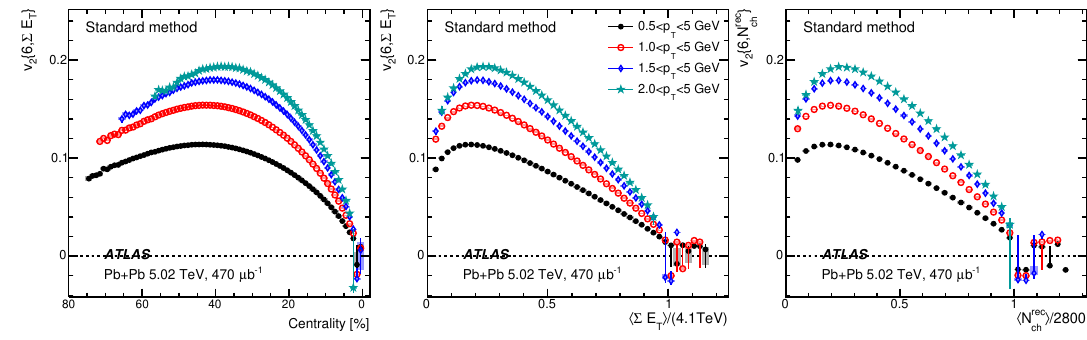
Figure 24 . The v 2 f 6 g values calculated for charged particles in four p T ranges as a function of centrality (left panel), (cid:6) E T (middle panel), and N rec boxes represent the statistical and systematic uncertainties, respectively. Zero is indicated by a dotted line.